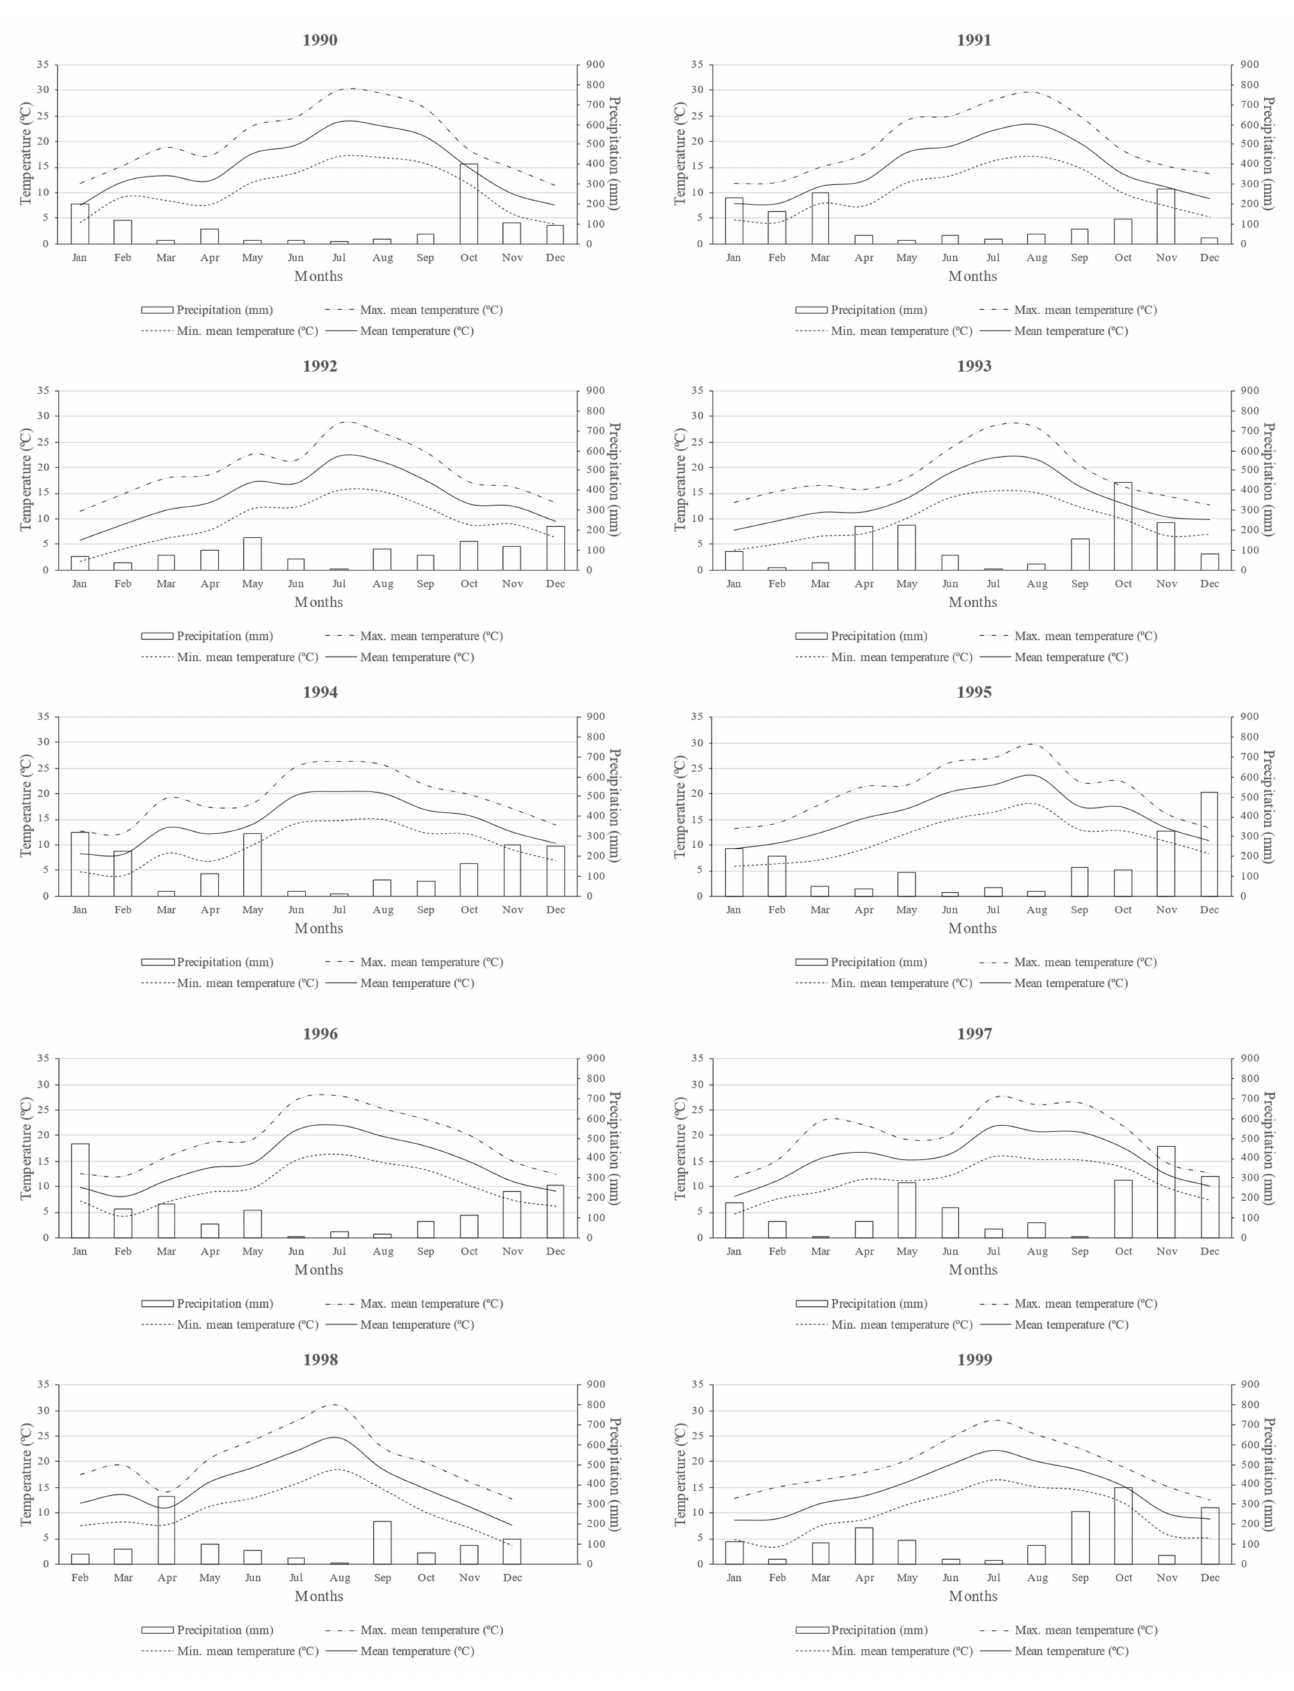
Figure 4. Distribution of climatic parameters for the decade of